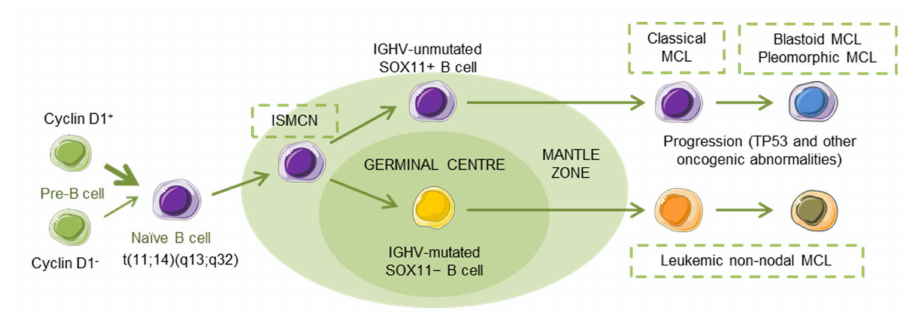
Figure 1. Hypothetical models of major mantle cell lymphoma (MCL) subtypes. Precursor B cells may colonize the inner portion of the mantle zone, representing in situ mantle cell neoplasia (ISMCN). After the introduction of additional genetic and molecular abnormalities, ISMCN may progress, involving or not the transit through the germinal center (GC), to classical MCL or leukemic non-nodal MCL, respectively. More frequently, classical MCL but also leukemic non-nodal MCL undergo additional molecular / cytogenetic abnormalities leading to clinical and sometimes to morphological progression. Adapted from Swerdlow et al.